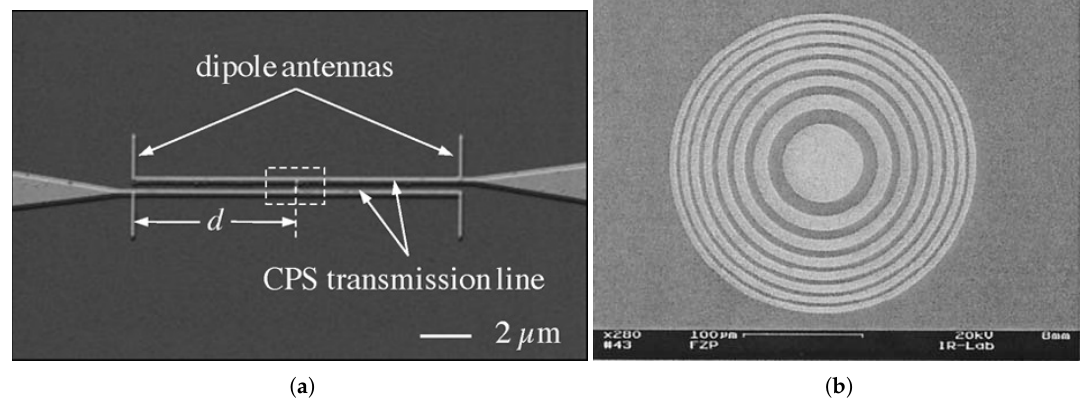
Figure 11. Effective area increase approaches: ( a ) Two elements phased array [44], ( b ) Fresnel zone structure [62].